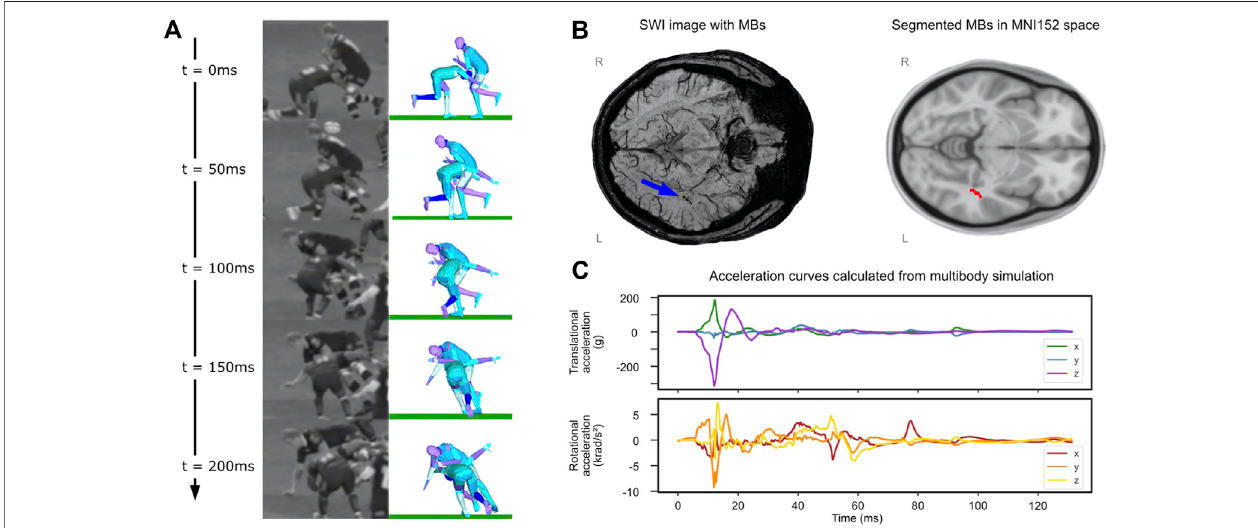
FIGURE5| Rugbycollisionresults. (A) Comparisonofreconstructiontovideoat50 msintervals,patientofinterestistacklingplayerontheleftatt=0. (B) (left)SWI image with microbleeds identi fi ed by blue arrow and (right) segmented microbleed in MNI5152 space. (C) Translational and rotational accelerations of player ’ s head taken from the multibody